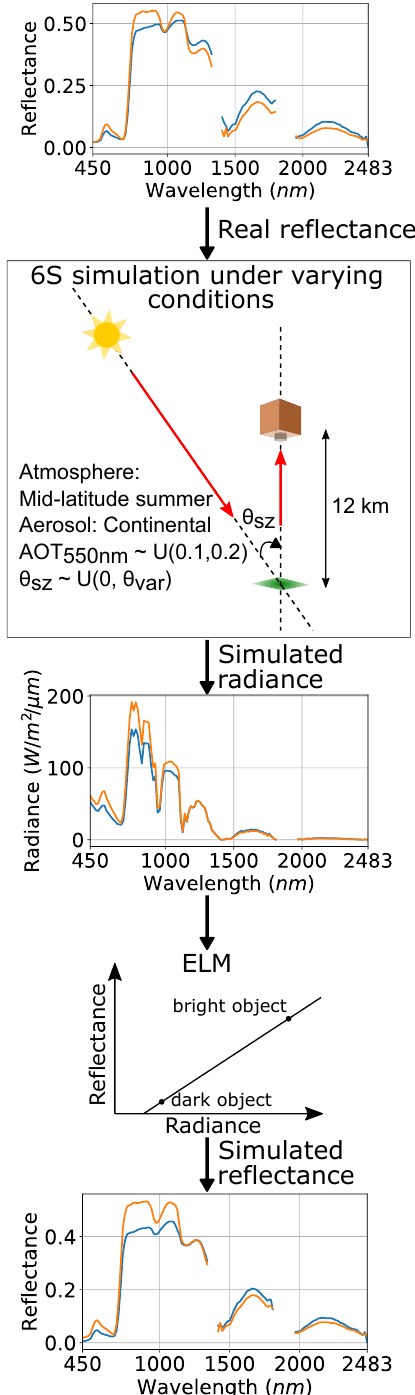
Figure 2. Pipeline to generate synthetic